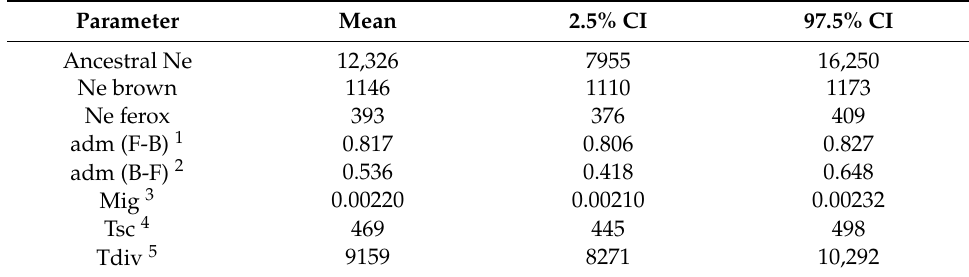
Table legend: 1 ln(likelihood), 2 Akaike information criterion. Table 4. Mean parameter estimates and confidence intervals (CI) for the secondary contact with introgression demographic model. Table legend: 1 Admixture proportion from ferox into benthivorous brown trout; 1,2 Admixture proportion from benthivorous brown trout into ferox trout; 3 symmetric bi-directional migration rates; 4 Timing of secondary contact and 5 divergence time in generations. Effective population sizes (Ne) are given in number of diploid individuals. Table 4. Selection of demographic models.